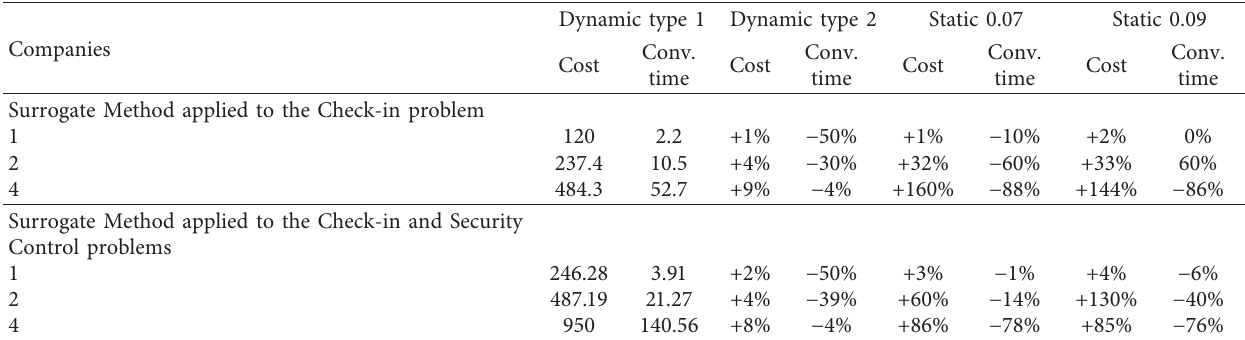
Table 6: Performance of the Surrogate